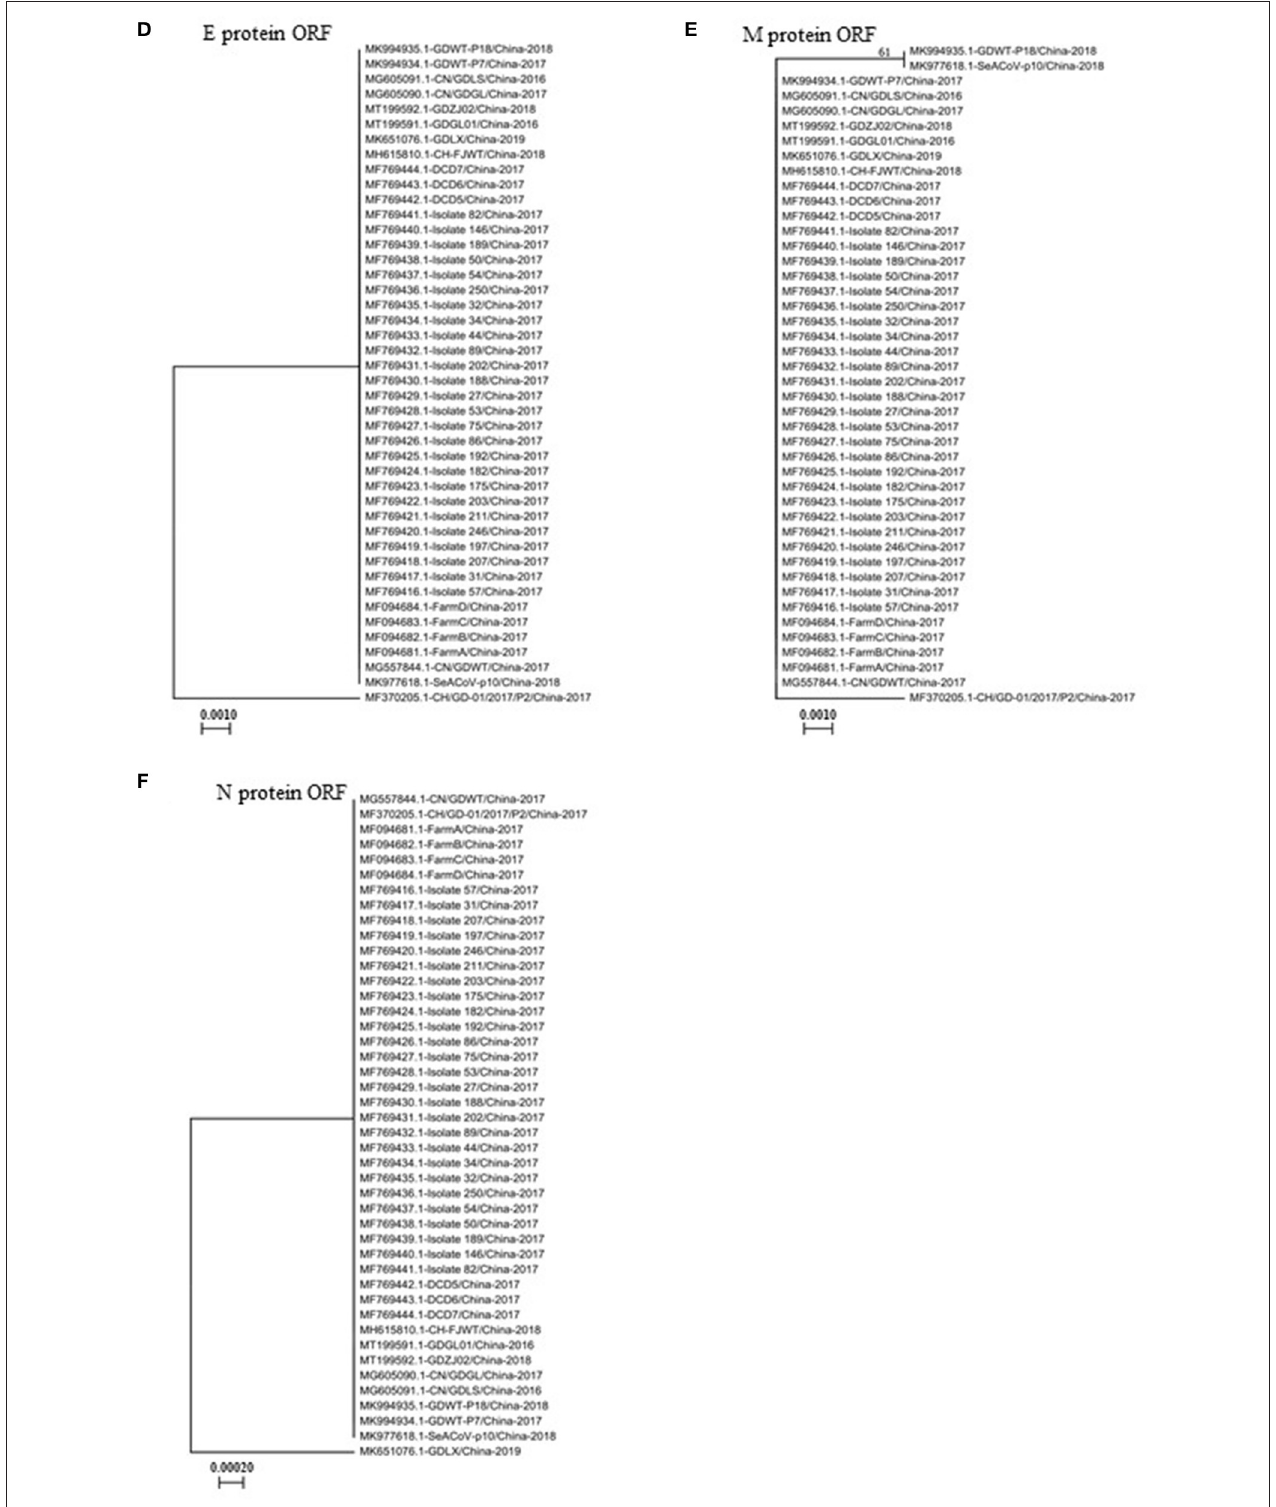
FIGURE 1 | The phylogenetic trees based on the whole genomes of SADS-CoVs (A) or the full-length spike glycoprotein ORF (B) , ORF1a and ORF1b (C) , or E protein ORF (D) , M protein ORF (E) , or N protein ORF (F) . Multiple-sequence alignments were performed using Clustal Omega server and then phylogenetic